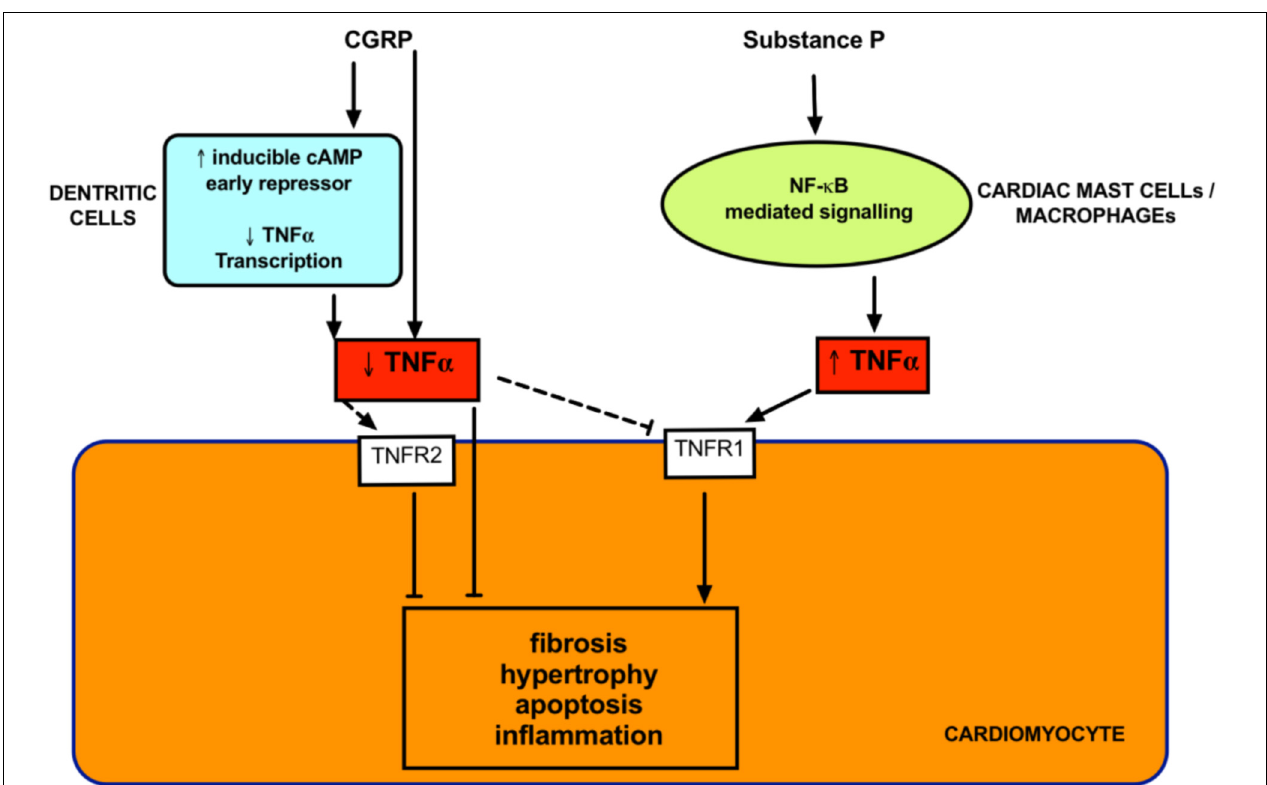
FIGURE 5 | Proposed direct cardiac effects of neuropeptides. Both Substance P and CGRP modulate tumor necrosis factor α (TNF α ) signaling. TNF- α is crucial in mediating cardiac remodeling and these effects can occur via activation of receptors (TNFR1 and TNFR2) on cardiomyocytes. Substance P promotes cardiac remodeling via TNF α release from inflammatory cells. CGRP inhibits TNF α and decreases remodeling in diseased models. Dashed lines indicates unknown but postulated